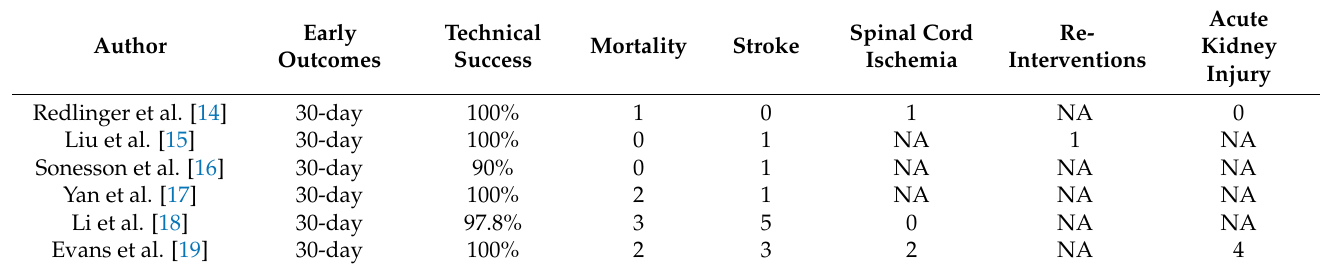
Table 3. Early outcomes including mortality, morbidity, and re-interventions in patients managed with in situ laser FTEVAR.